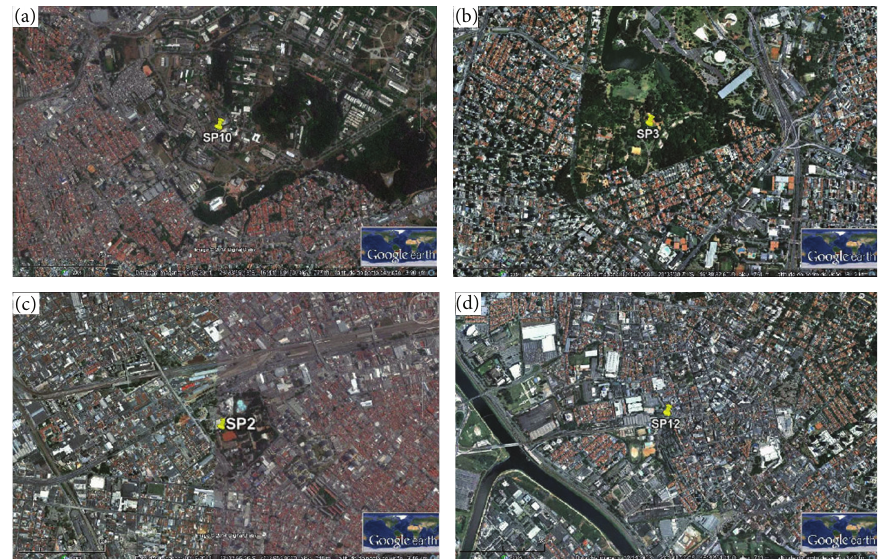
Figure 7: Image of stations. (a) SP10 (source: Google Earth, 16 Oct 2014, 08 Dec 2014), (b) SP3 (source: Google Earth, 14 Dec 2008, 08 Dec 2014), (c) SP2 (source: Google Earth, 16 Oct 2014, 08 Dec 2014), and (d) SP12 (source: Google Earth, 14 Dec 2008, 08 Dec 2014).